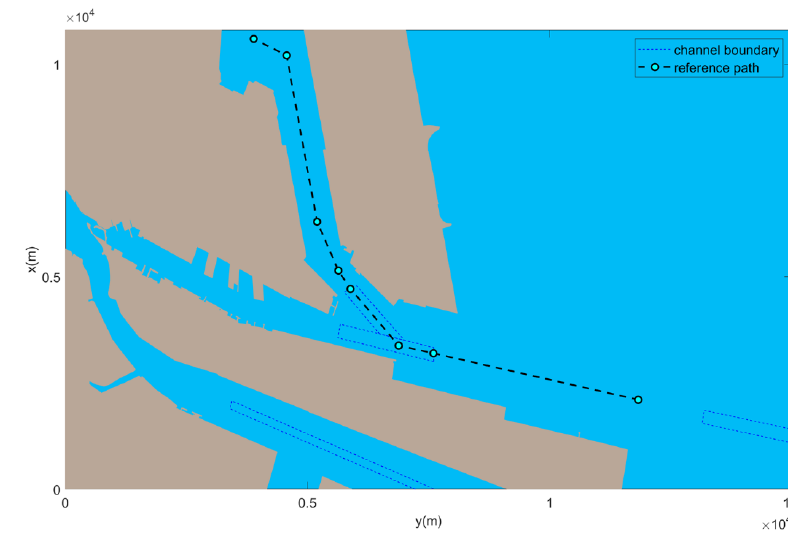
Figure 13. Results of path planning for narrow waterways.